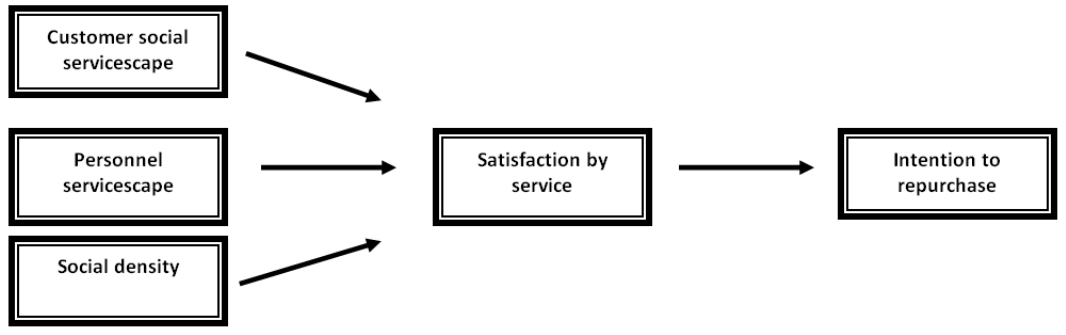
Figure 1. The contextual model of the study.